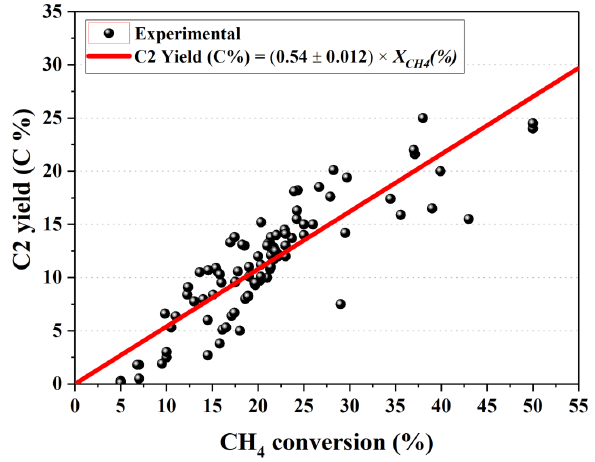
Figure 34. Experimental C2 yields as a function of methane conversion for trimetallic oxides. Data sources are indicated in the text.